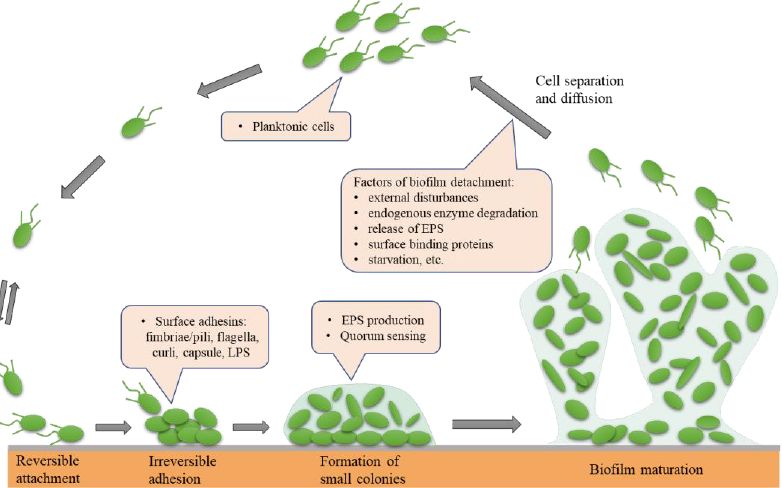
Figure 1. The five main phases leading to the development and formation of biofilm: (1) reversible attachment; (2) irreversible adhesion; (3) early development of biofilm structure (formation of small colonies); (4) biofilm maturation; (5) cell separation and diffusion.